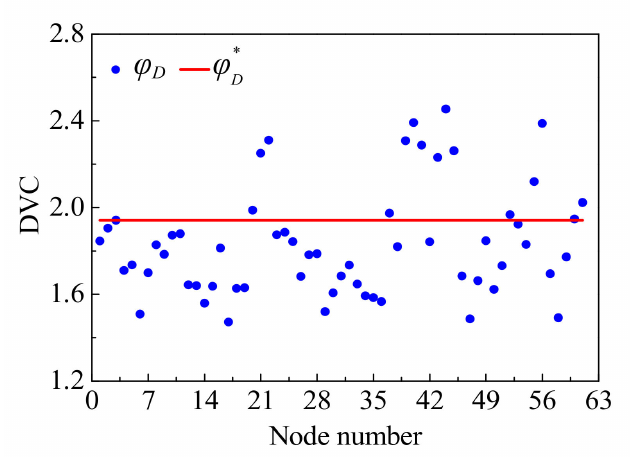
Figure 8. Comparison of the DVC of nodal displacement and the global DVC of displacement.